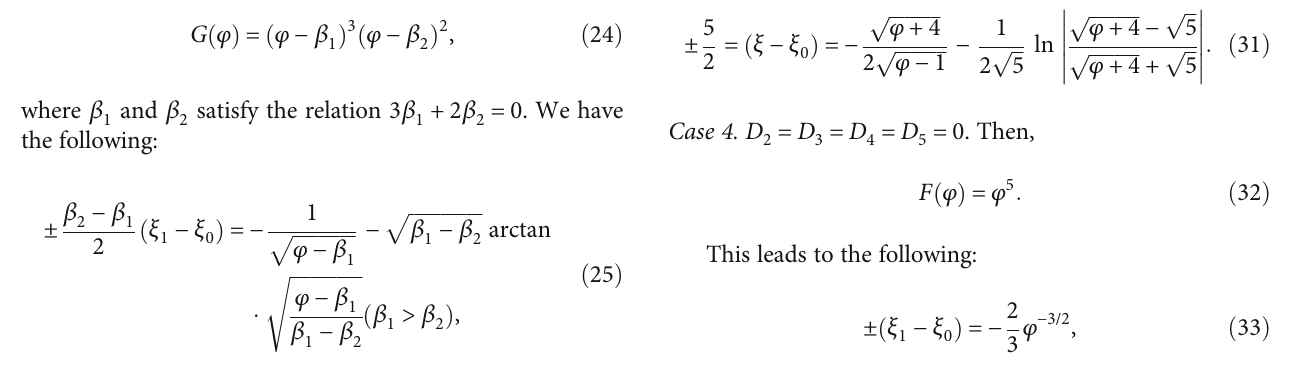
ffiffiffi p ln 2 5